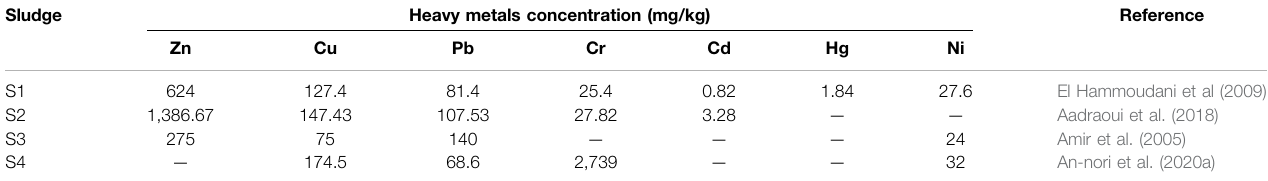
TABLE 3 | Concentration (mg/Kg) of heavy metals in different types of sludge. S1 and S2: raw biological sludge. S3: composted sludge and S4: solar-dried sludge. Sludge